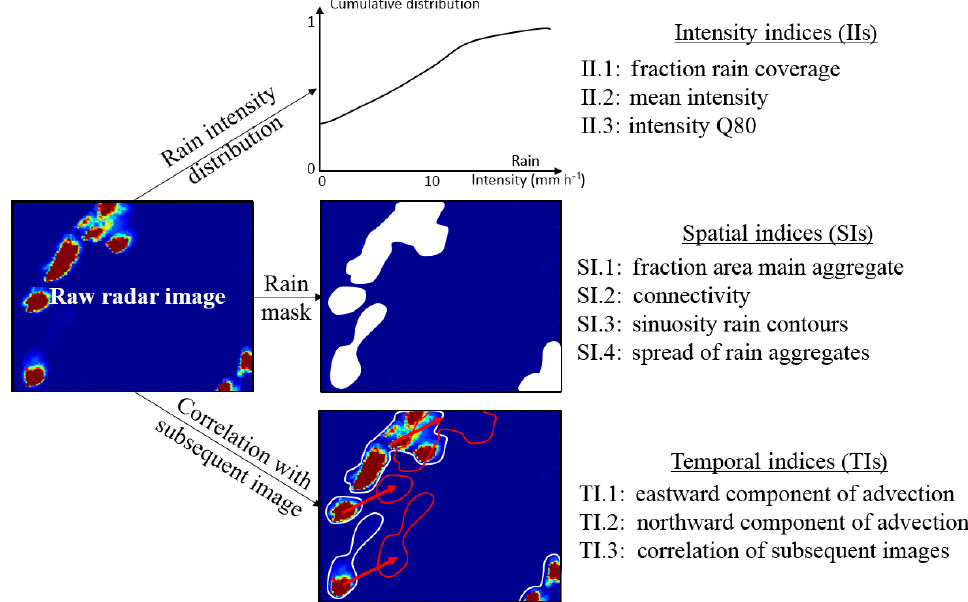
Figure 2. Computation of indices characterizing rainfall space–time statistics for a single radar image. This procedure is repeated for each image with > 10% rainy pixels. Note that the temporally subsequent image is required to compute the time indices